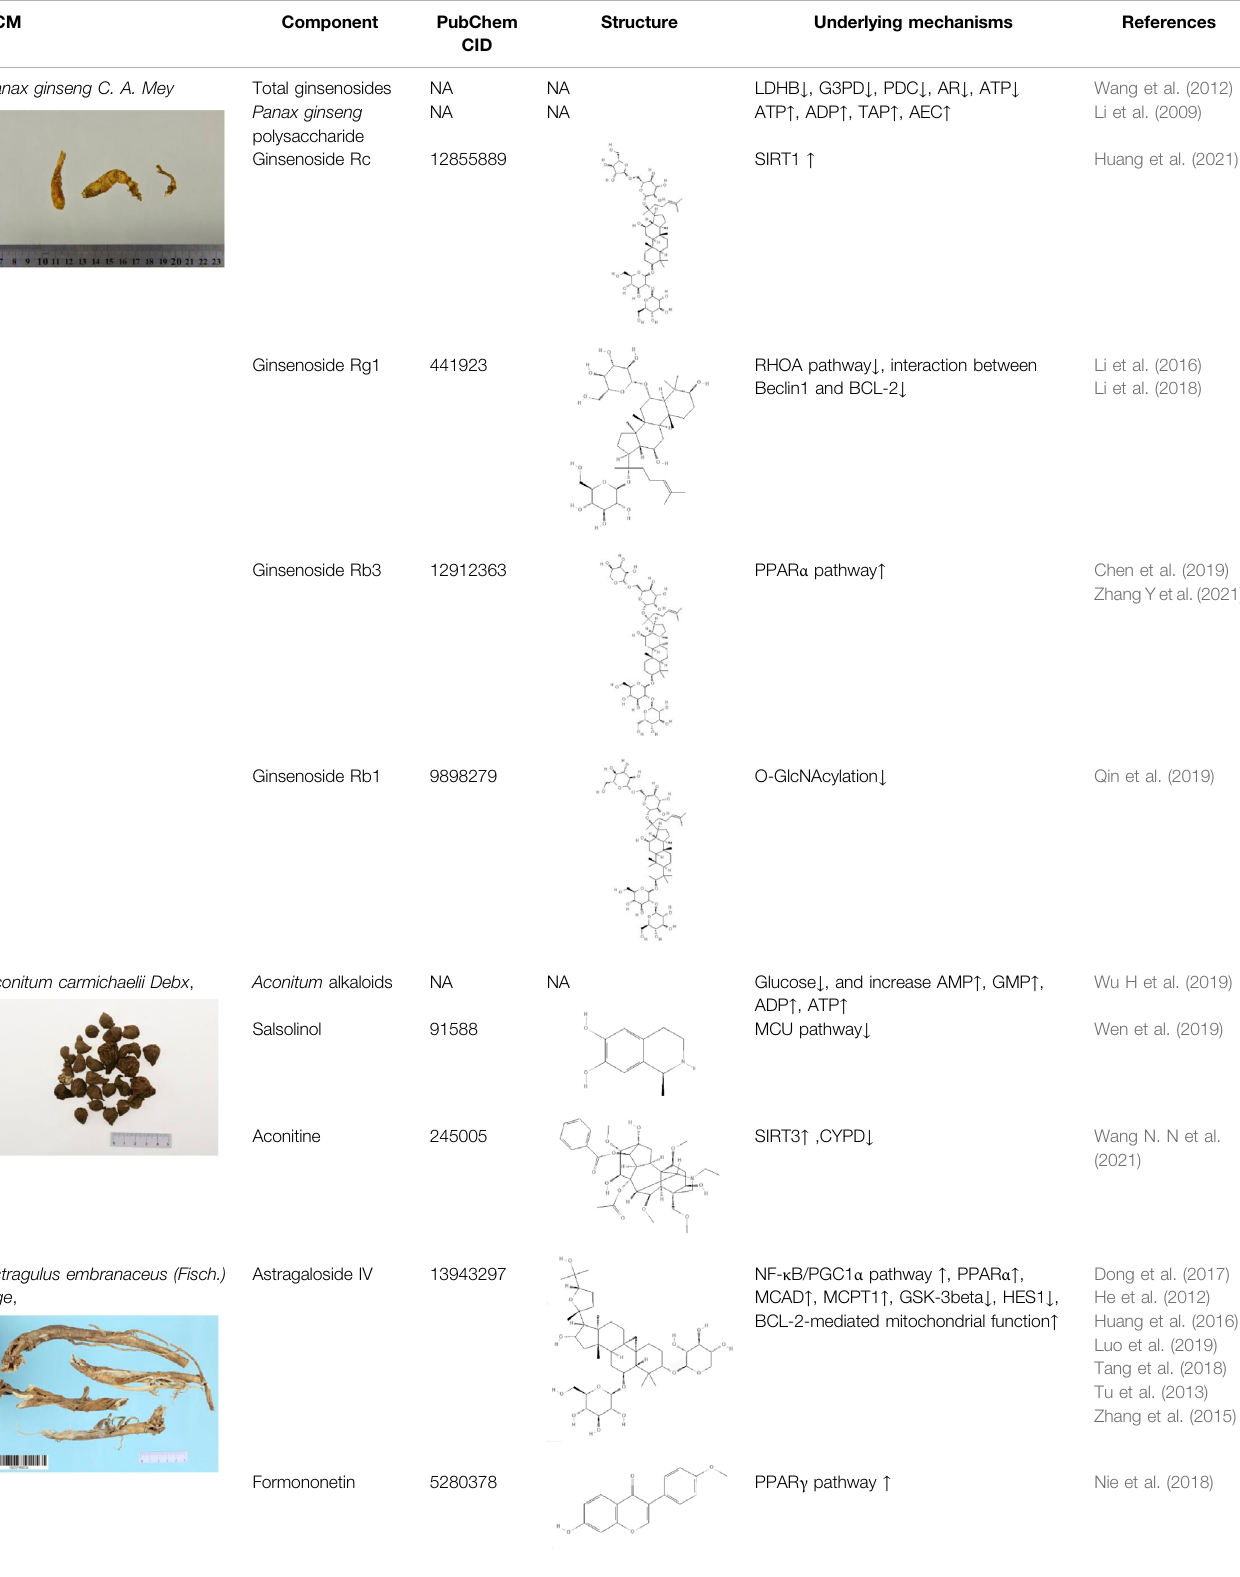
TABLE 3 | The mechanisms of TCM in improving energy